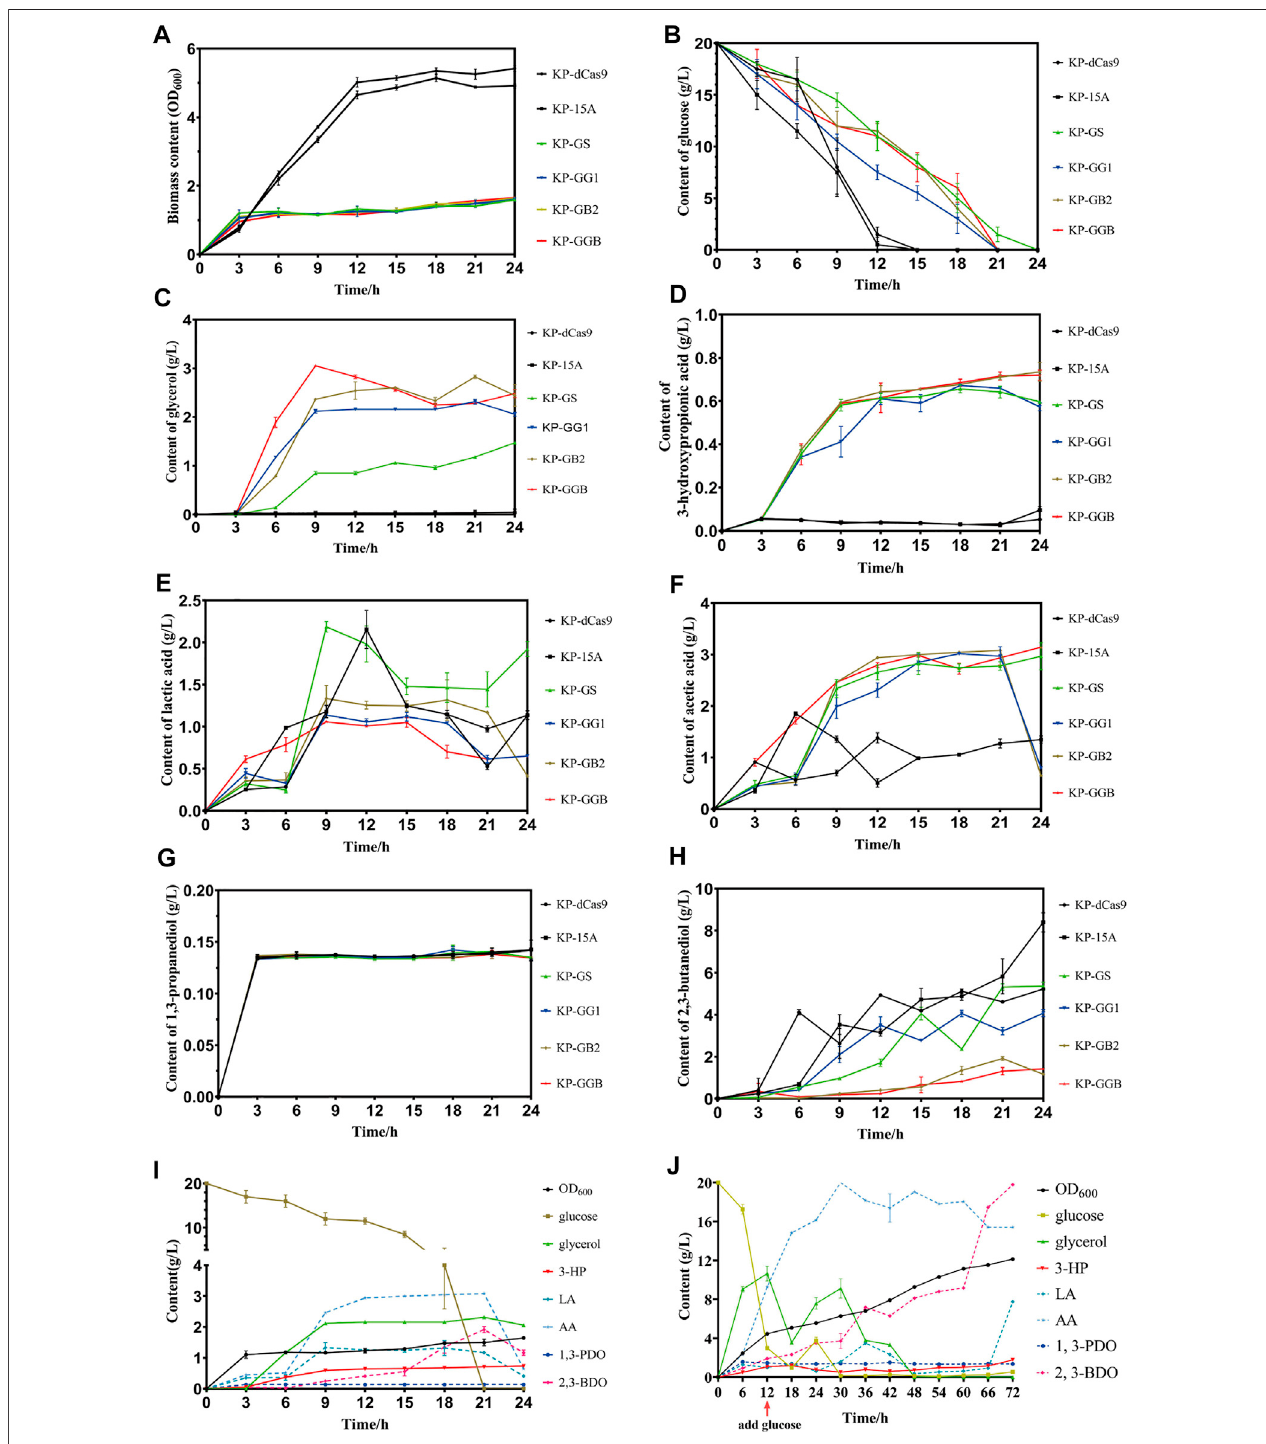
FIGURE 5 | Fermentation of strain harboring CRISPRi system to repress by-product pathways. (A) Biomass (OD 600 ) of the CRISPRi strain in the shake fl ask. (B) Glucose consumption of CRISPRi strain in the shake fl ask. (C) Glycerol production by CRISPRi strain in the shake fl ask. (D) 3-Hydroxypropionic acid production by CRISPRistrainintheshake fl ask. (E) LacticacidproductionbyCRISPRistrainintheshake fl ask. (F) AceticacidproductionbyCRISPRistrainintheshake fl ask. (G) 1,3- Propanediol production of CRISPRi strain in the shake fl ask. (H) 2,3-Butanediol production by CRISPRi strain in the shake fl ask. (I) Metabolites of CRISPRi strain KP-GB2 in the shake fl ask. (J) Metabolites of CRISPRi strain KP-GB2 in fed-batch culture. KP-dCas9, the recombinant K. pneumoniae strain with dCas9 integrated in genome;KP-15A,therecombinant K.pneumoniae strainharboring empty vectorptac-15A; KP-GS, therecombinant K.pneumoniae withdCas9integratedingenome,